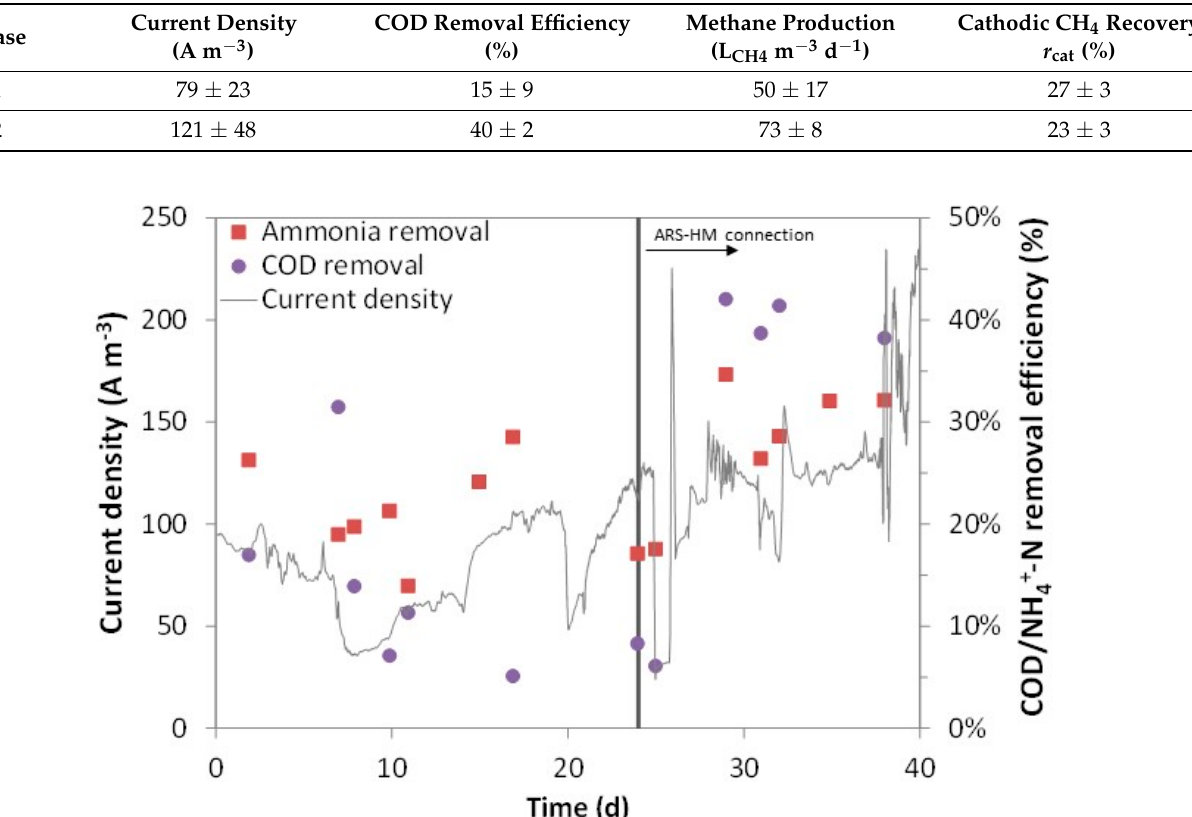
Figure 2. Current density production of the MEC and chemical oxygen demand (COD) and ammonium nitrogen (NH 4+ -N) removal efficiencies, in the periods of MEC operation with disconnected and connected hydrophobic membrane system (ARS-HM). Table 2. Average values for the main performance parameters of the MEC related to methane pro- duction.